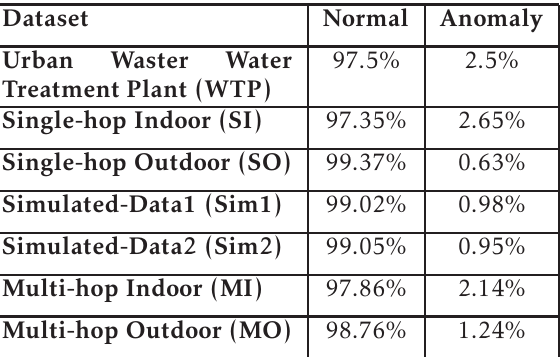
Table 2. Characteristics of the SCADA